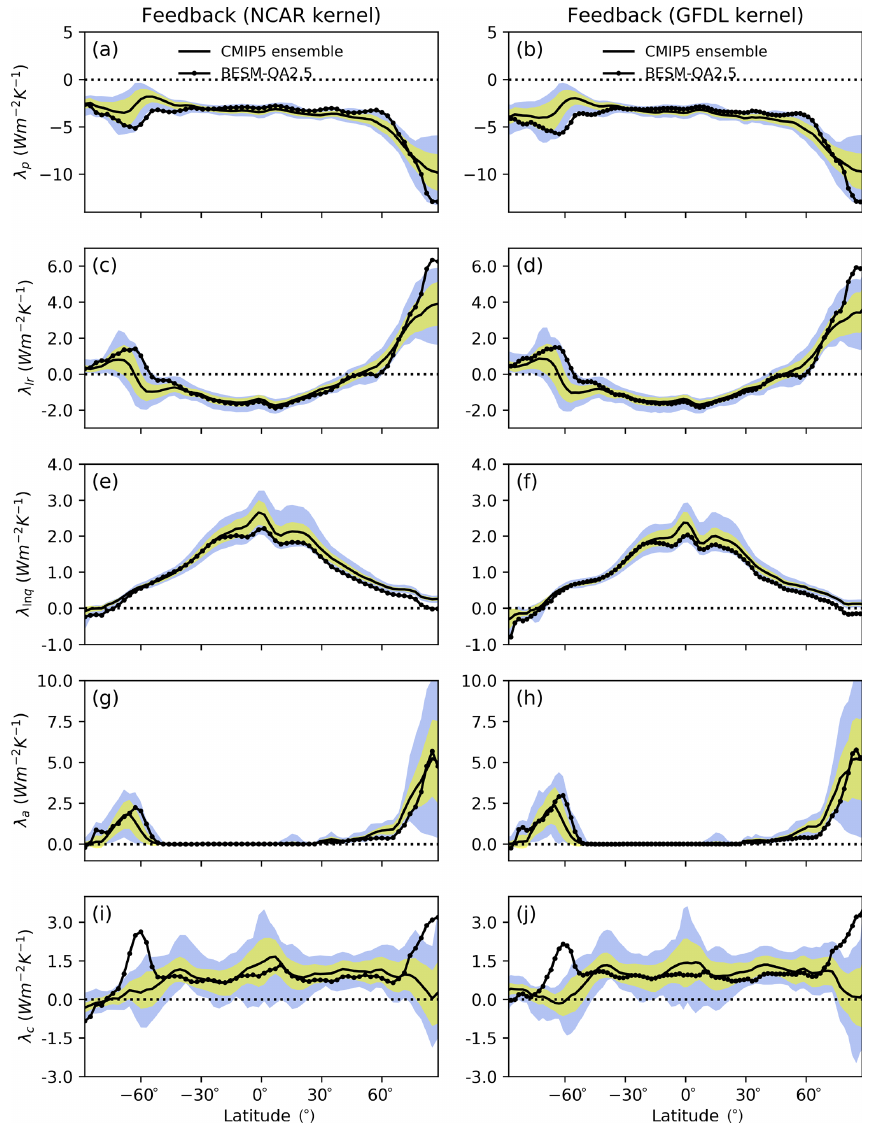
Figure 4. Feedbacks for the CMIP5 multi-model ensemble mean (solid line) and BESM-OA2.5 (solid line with dots) for the Planck feed- back (a, b) , lapse rate feedback (c, d) , water vapor feedback (e, f) , albedo feedback (g, h) , and cloud feedback (i, j) . Inter-model standard deviations for each latitude are in yellow. In blue are the feedback limits based on the maximum and minimum values for each latitude among the models, excluding BESM-OA2.5. All feedbacks are based on the averaged over years